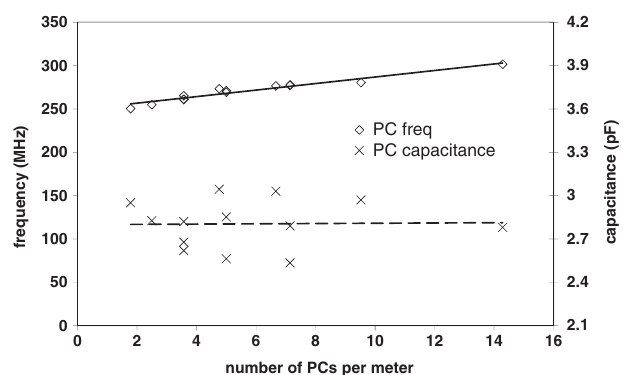
FIG. 6. PC mode frequency and PC capacitance C 1 simulations of different distributions of PCs inside the tank. Simulation settings are: gap PC - DT ¼ 3 mm , drift tube radius ¼ 45 mm , tank radius ¼ 260 mm ; PC radius ¼ 10 mm .